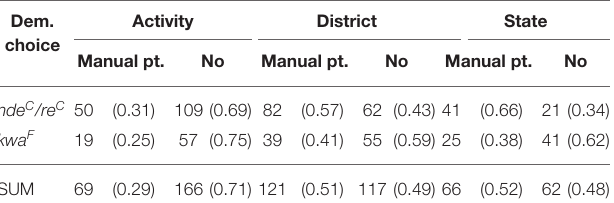
TABLE 10 | Raw frequencies (proportion) of demonstrative forms and manual points at the activity, district, and state scales. Dem. Activity District State choice Manual pt. No Manual pt. No Manual pt.